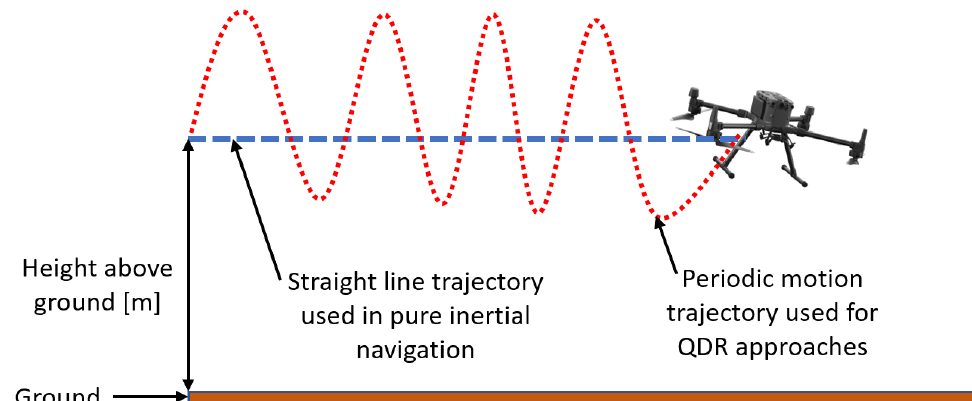
Figure 1. Illustration of a periodic motion used in the QDR